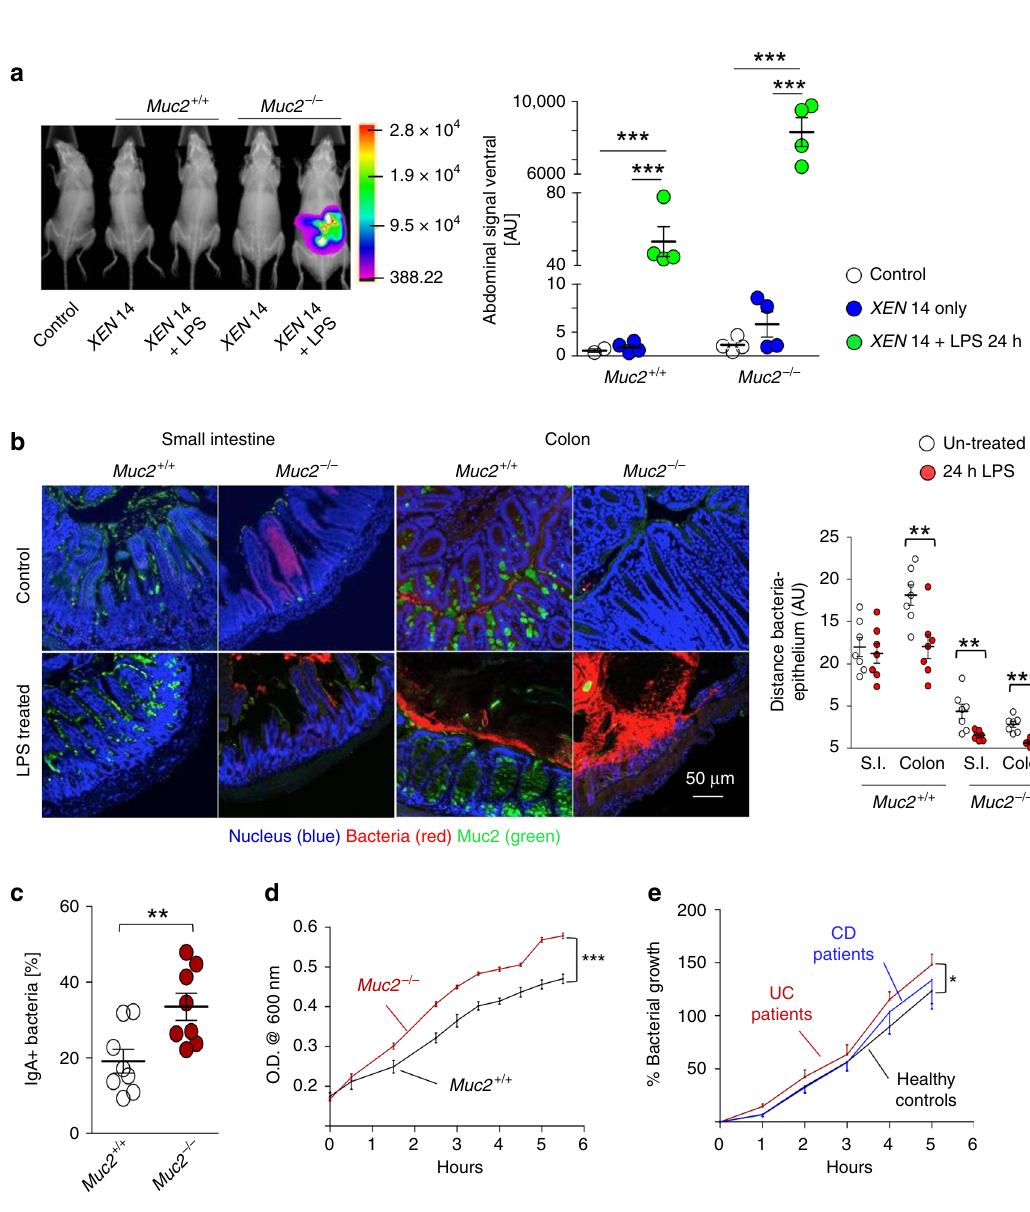
Fig. 3 Increased bacterial translocation in Muc2 − / − littermates. a Bioluminescence of XEN -14 E. coli treated and control animals were recorded post 24 h LPS treatment. LPS-treated Muc2 − / − exhibited increased luminescence corresponding to higher translocation of intestinal bacteria as compared to Muc2 + / + littermates. Graph shows representative data from two independent experiments. b Fluorescence in situ hybridization (FISH) using Alexa 555- conjugated EUB338 universal probe for bacterial rRNA in mouse intestinal tissue 24 h post LPS challenge to visualize translocated gut bacteria. Tissues were fi xed in Carnoy ’ s, paraf fi n embedded, sectioned, and FISH staining was done using established protocol. Nucleus was stained with DAPI and mucus with UEA1-TRITC lectin. Representative images are from three independent experiment, n = 3. Graph shows distance calculated from epithelium to the nearest bacteria (select straight line from epithelium to the bacteria and then analysis tab). In total 25 events were calculated from each area of view and plotted as Means ± SEM. c Quanti fi cation of fecal IgA + bacteria in Muc2 − / − and Muc2 + / + littermates. Age and sex-matched animals were used to collect fecal samples in sterile condition. Graph shows cumulative data of two independent experiments ( n = 5/experiment) and plotted as mean ± SEM. d , e Higher bacterial growth in the serum of d Muc2 − / − littermates ( n = 10) and e active UC patients, suggesting higher predisposition towards septicemia ( n = 5/group). A fi xed number of non-pathogenic E. coli was added to heat-inactivated serum and O.D. was recorded at given time points at 600 nm. Data are representative of three independent experiments, paired one-way ANOVA. Data are presented as means± SEM. * p < 0.05, ** p < 0.01, and *** p <